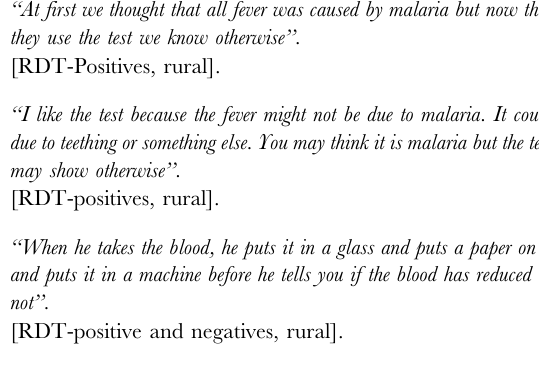
Variable Worried about ACT denial because of RDT-negative result Demographic